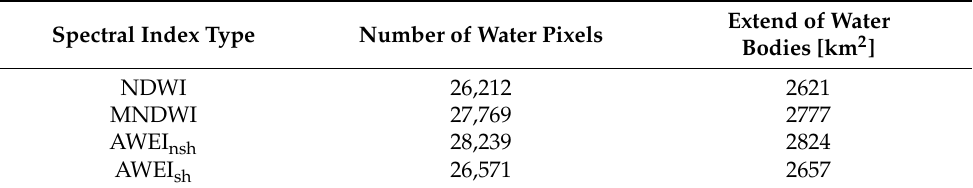
Table 6. Numerical comparison of water masks pixels and extend of water bodies by four spectral indices in the selected area.